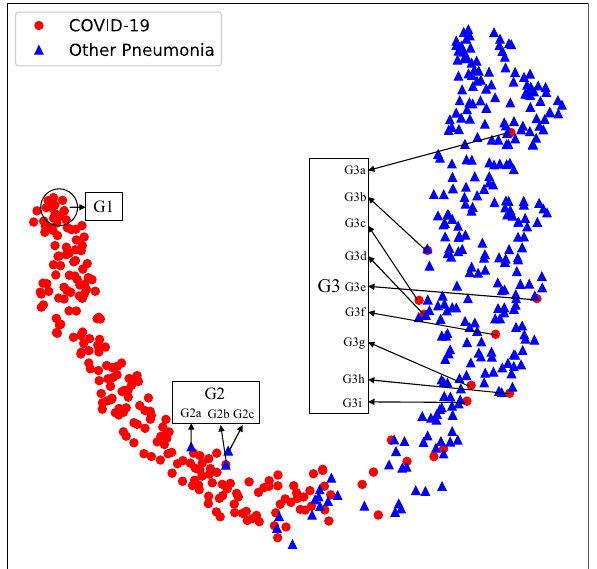
Figure 2. t-SNE of CT images of COVID-19 and other causes of pneumonia on the secondary test dataset. G1 depicted chest CT images of COVID-19 pneumonia with the highest differentiation. G2 represented three cases of false-positive prediction of COVIDNet. G3 pointed out nine cases of false-negative prediction of COVIDNet. CT image manifestations of G1 to G3 were illustrated in Supplementary Table